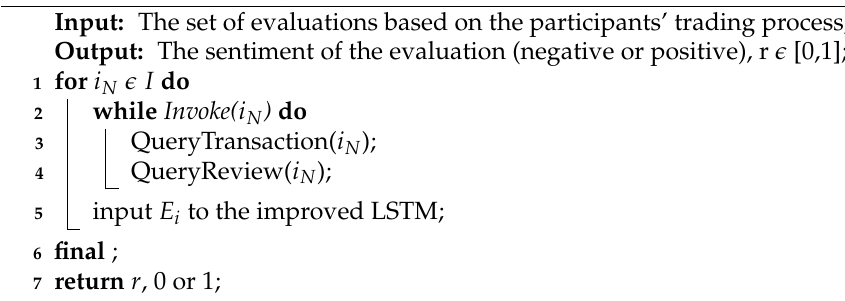
Algorithm 2: Obtaining sentiment analysis